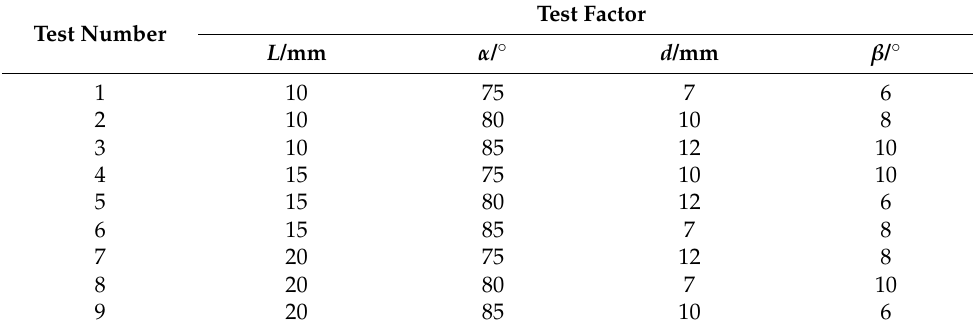
Figure 16. Slip structural parameters. Table 3. Orthogonal test scheme. Table 3. Orthogonal test scheme.